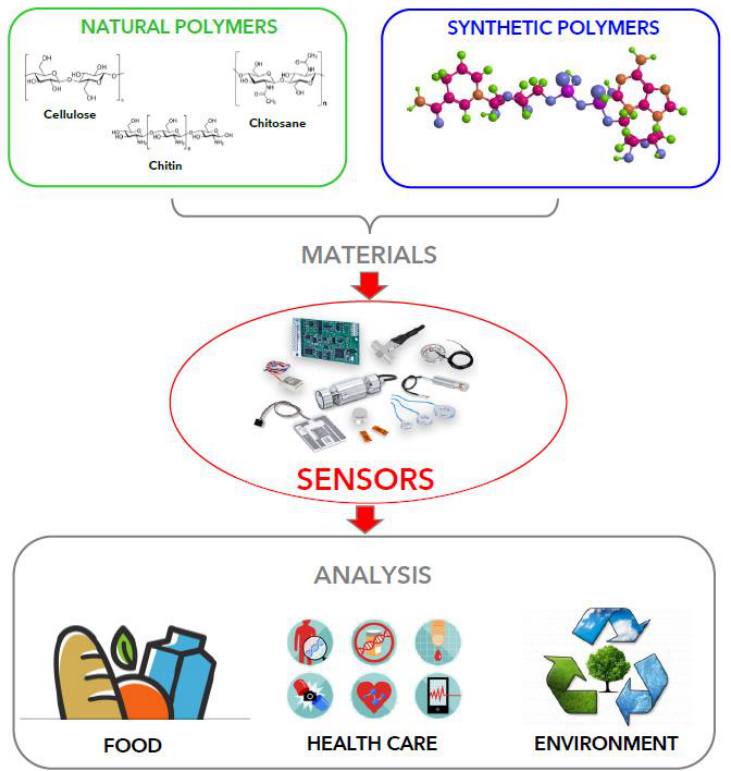
Figure 1. Overview image of polymer-based sensors described in this review.